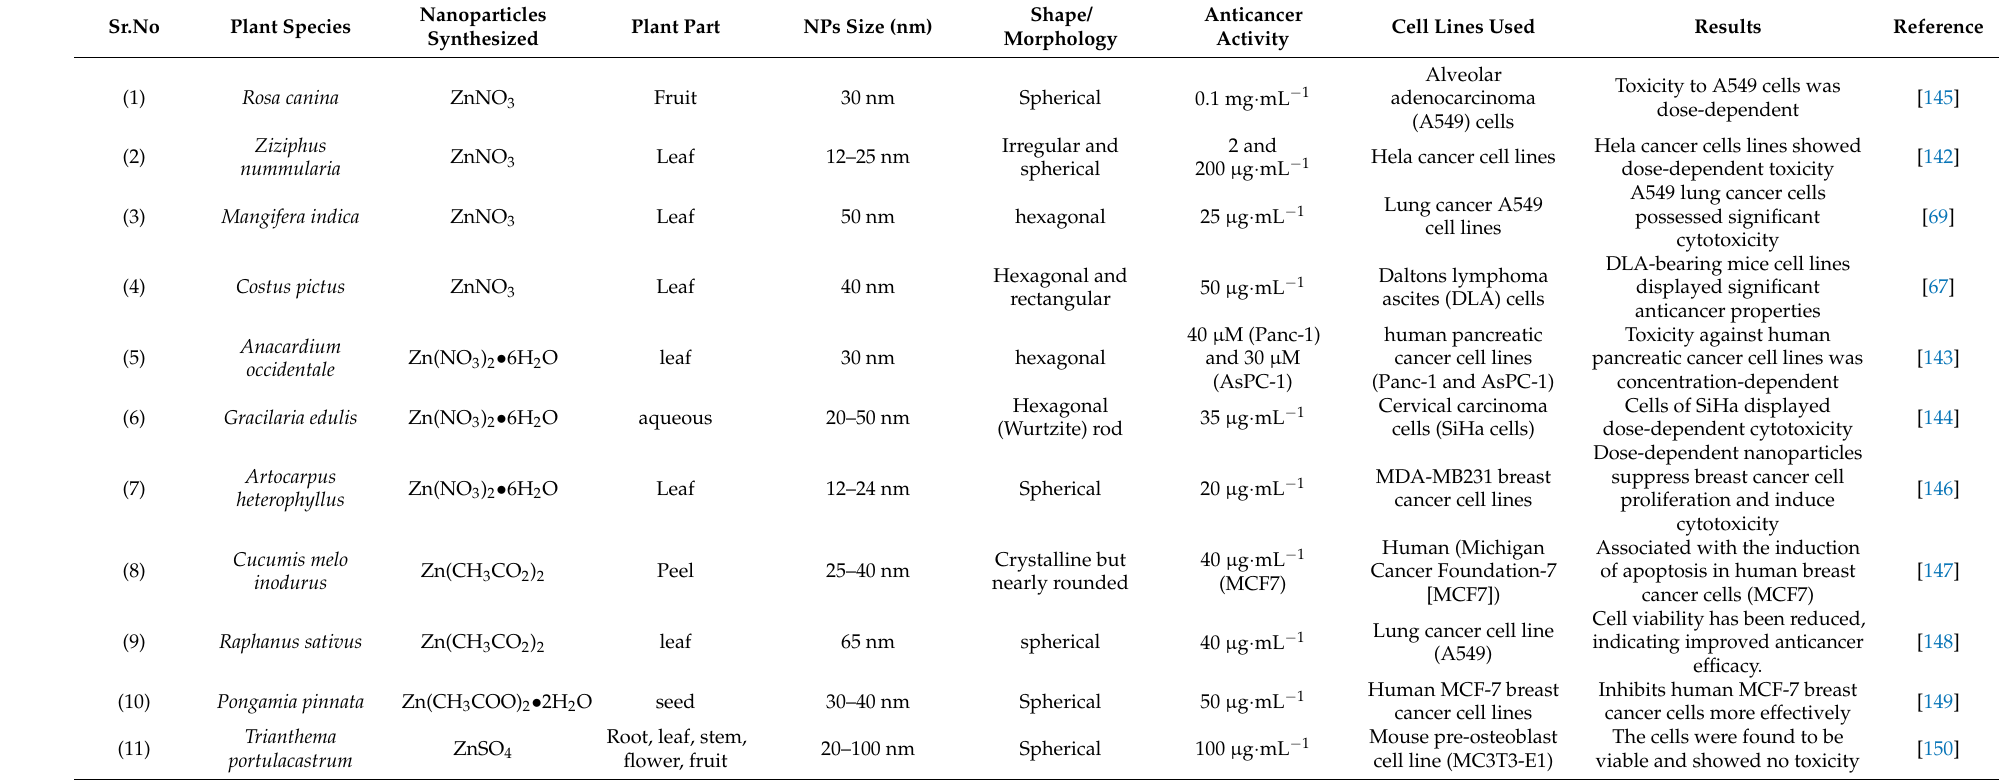
Table 2. Anticancer activity of biogenic zinc nanoparticle against different cell